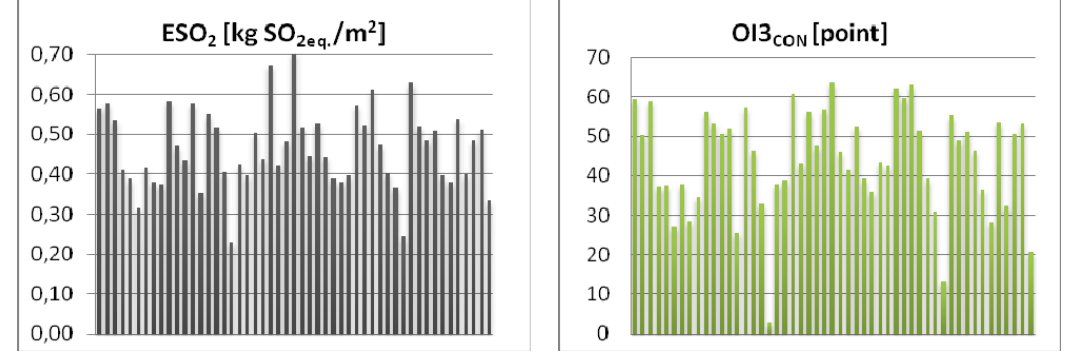
Figure 9. Environmental indicators of material compositions of on-the-ground floor structures.